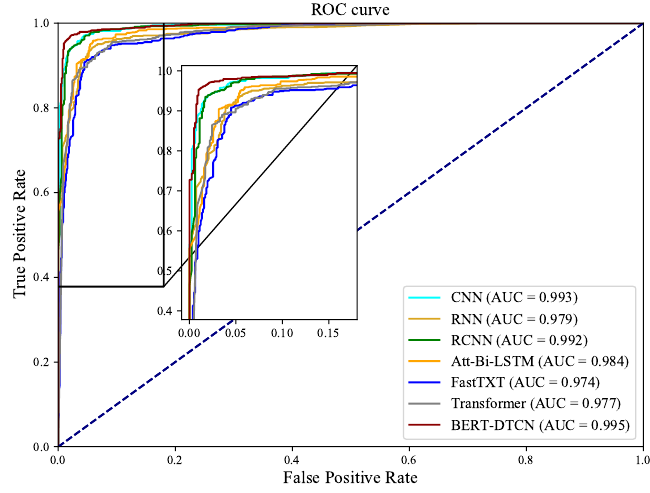
Figure 13. The ROC curves for BERT-DTCN and competing models.